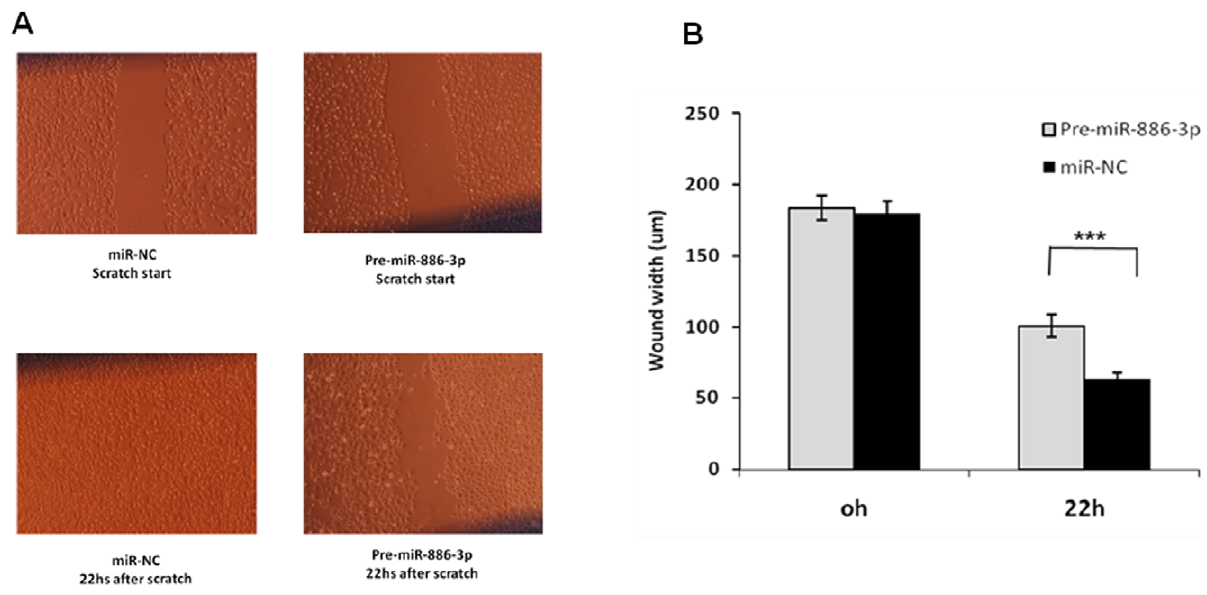
Figure 9. Overexpression of miR-886-3p inhibited migration of TPC-1 cells. Pre-miR-886-3p significantly decreased cell migration at 22 hours (p , 0.001). A ) Representative image of wound assay at time 0 and 22 hours after scratch. B ) Quantification of wound width closure with miR-886-3p overexpression. Six different locations were visualized and photographed under a phase-contrast inverted microscope (10 6 magnification) in each plate at different time points, and three plates were used for each group. The wound width in the 10 6 images was measured using a standard caliper. The experiments were repeated three times, and similar results were observed. (*** indicates p , 0.001).